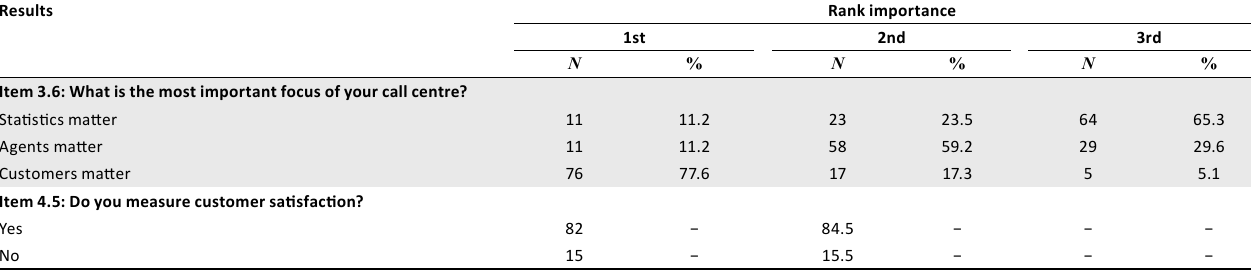
TABLE 6: The focus of the call centre.